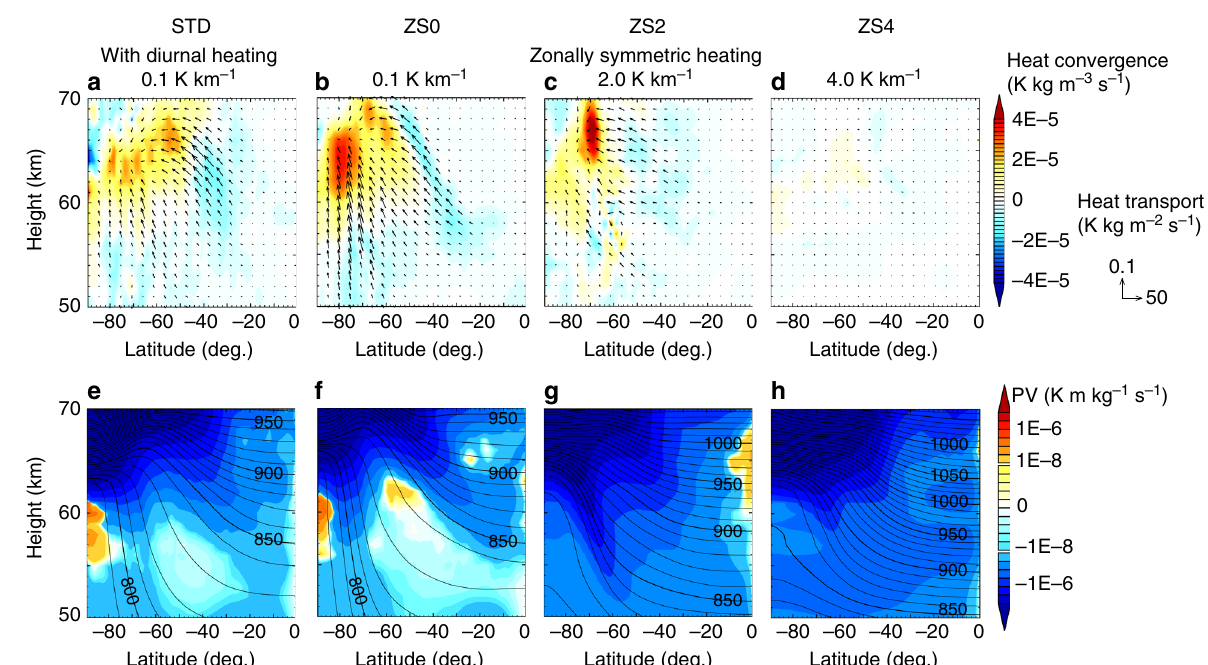
Fig. 5 Zonally and temporally averaged fi elds of eddy heat transport and potential vorticity (PV). Panels a – d show heat transport due to eddies by vectors and its convergence by colour, and e – h show PV by colour and potential temperature by contour. For the colouring of PV, a linear scale is used for the range between ±10 − 8 and a logarithmic scale is used for outside of the range to visualise the positive and negative PV-gradients. The time-average period is 30 Earth days (about 5 – 7 periods of the superrotation at 60 km height)